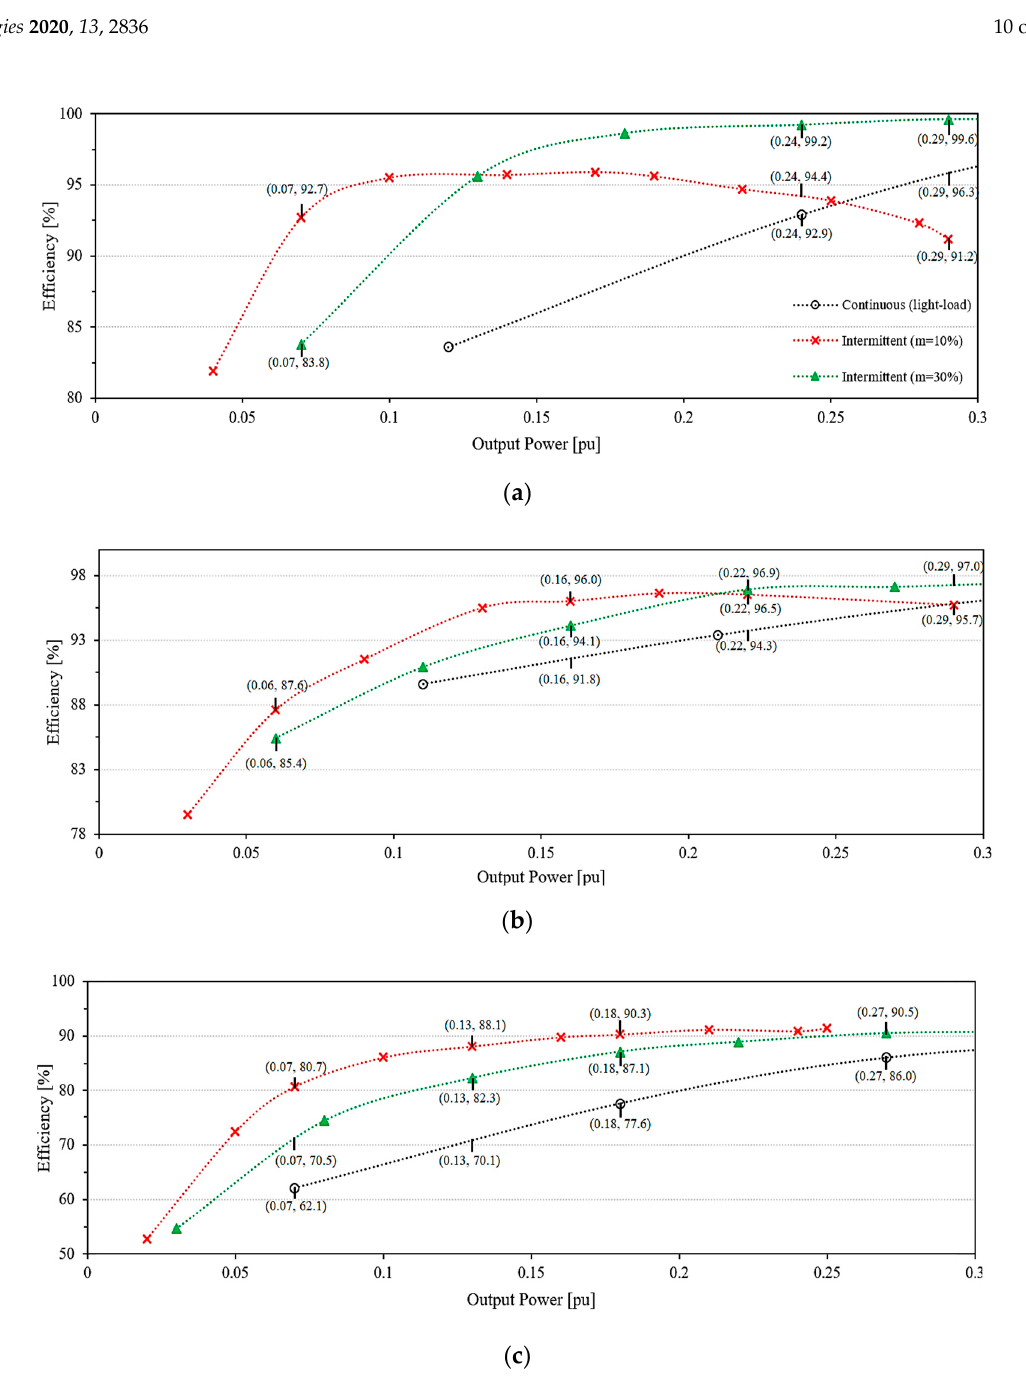
Figure 10. Efficiency versus output power curve of the 3P-BIDC with different transformer configurations in light-load conditions of less than 0.3 p.u. ( a ) Yy and Dd. ( b ) Yd. ( c ) Dy.